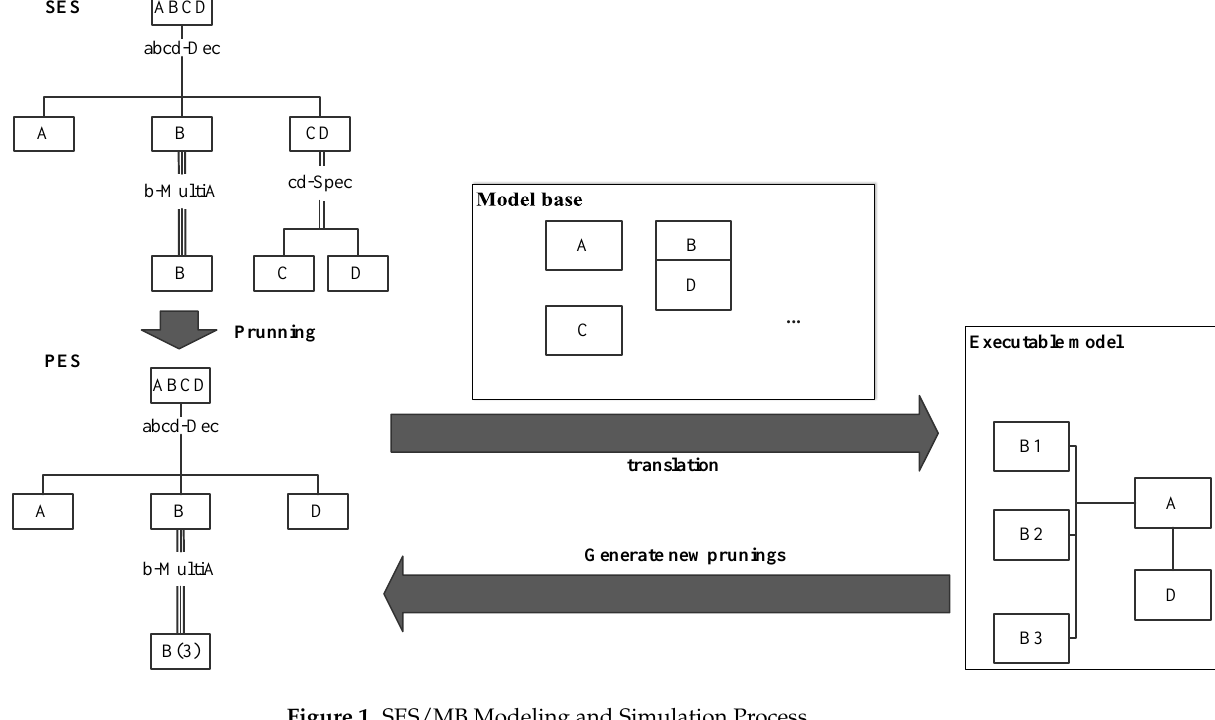
Figure 1. SES/MB Modeling and Simulation Process.